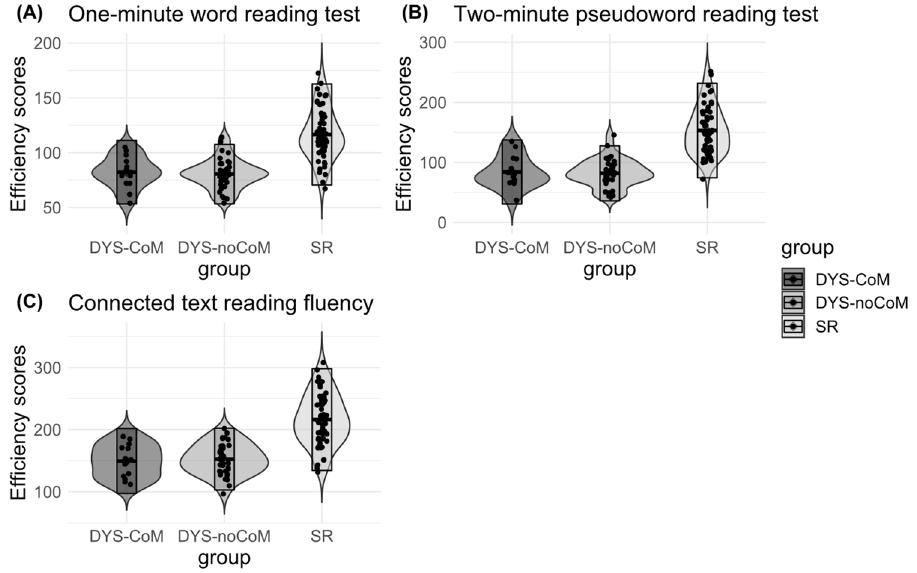
Figure 1. Reading performances of the three groups in three tests ( A ) One-minute word reading test; ( B ) Two-minute pseudo word reading test; ( C ) Connected text reading fluency) with mean, standard deviation, and sample points. Violin plots have the advantage of depicting the distribution of the data as well as their probability density. SR: Skilled readers, DYS-noCoM: Dyslexic readers without motor impairment), DYS-CoM: Dyslexic readers with motor impairment.